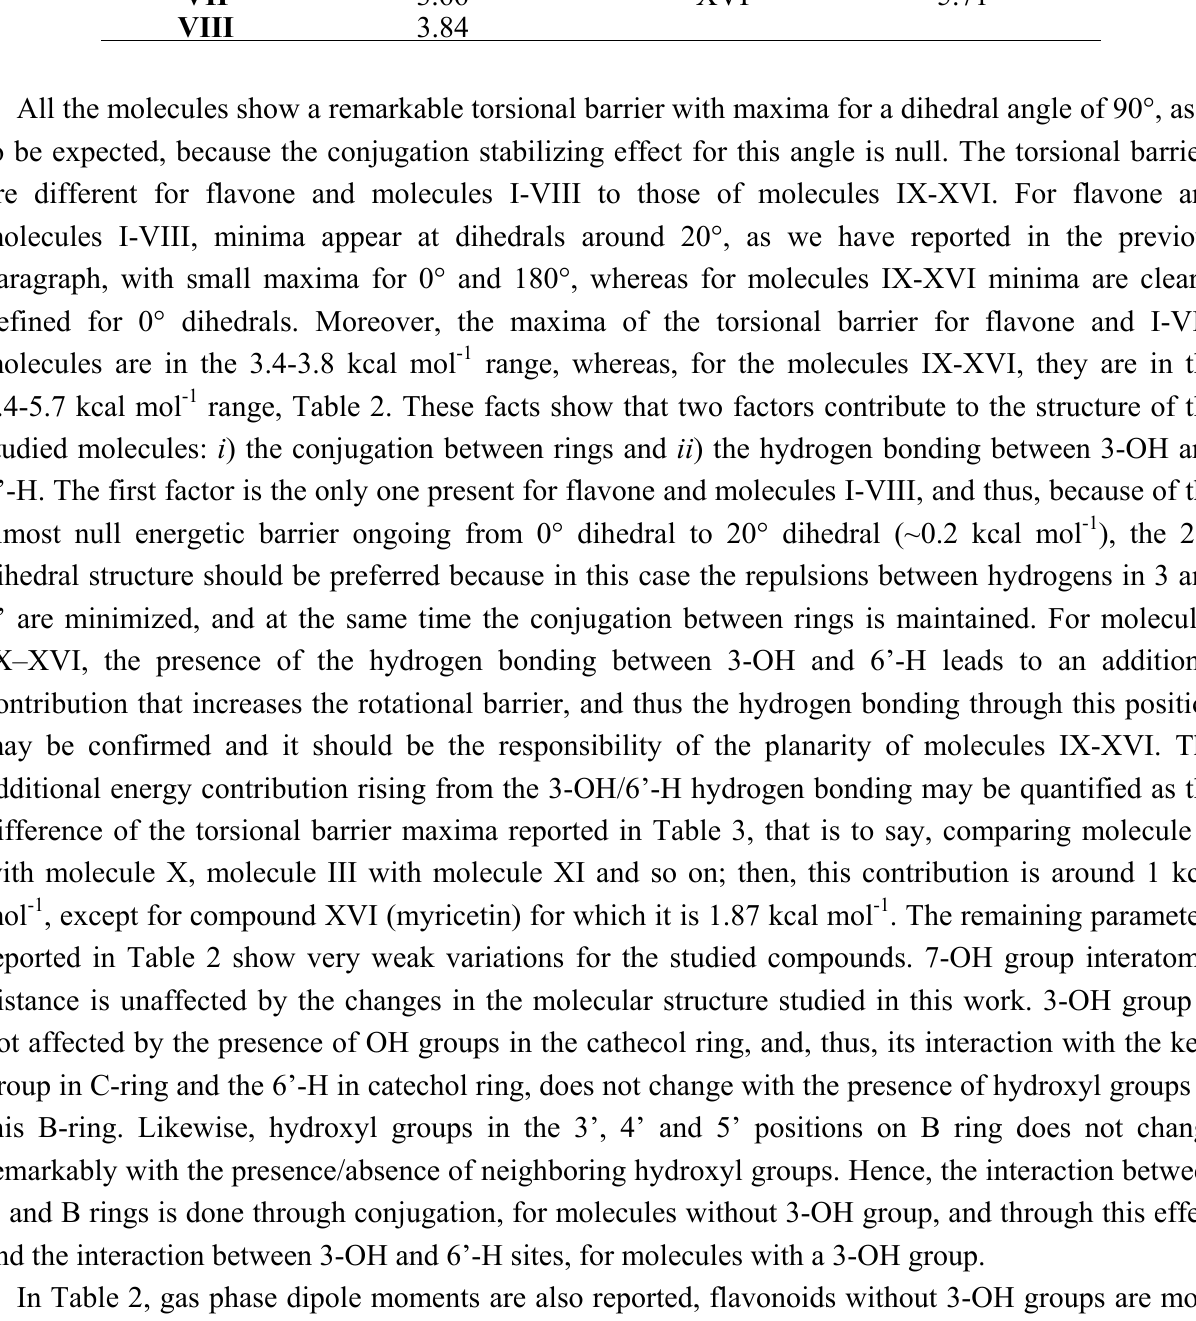
, for the rotation of the (3–2–1’–6’) max